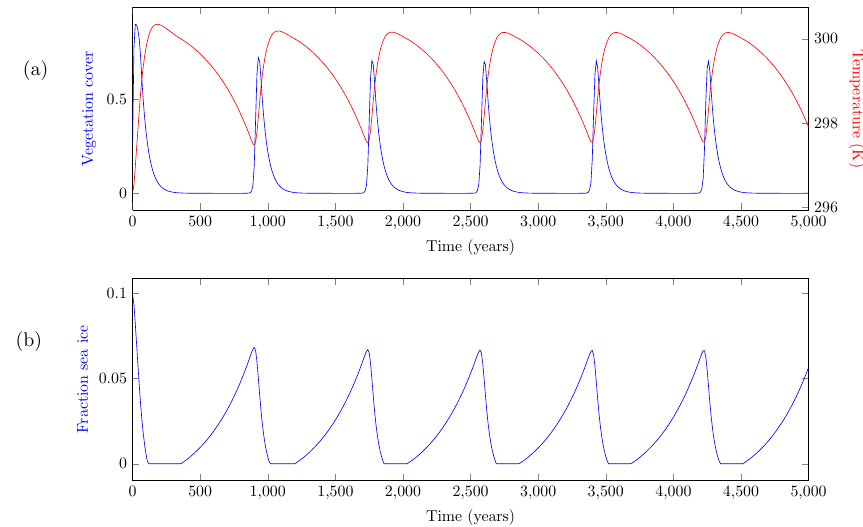
Figure 7. Typical oscillatory model solution, shown here for γ = 0.02; i.e., γ/C T = 1 / 10. (a) Temperature and vegetation cover; and (b) frac- tion of the ocean that is covered by sea ice. The period of these regular oscillations is a little under 1000